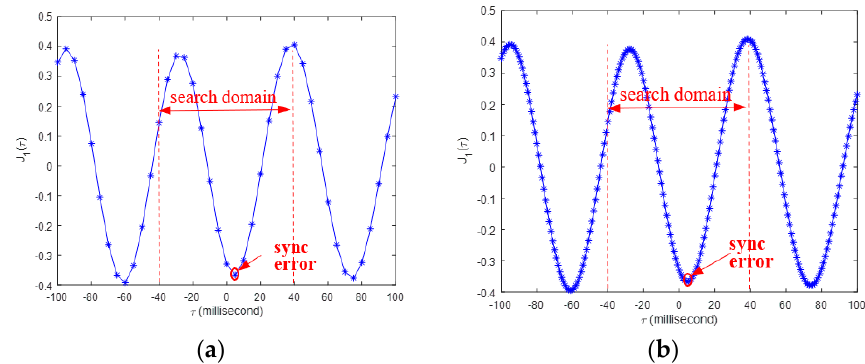
Figure 19. Time synchronization indexes J 1 ( τ ) of the 20 cm beam with di ff erent upsampling rates: Table 4. Time synchronization errors of cantilever beams (millisecond).